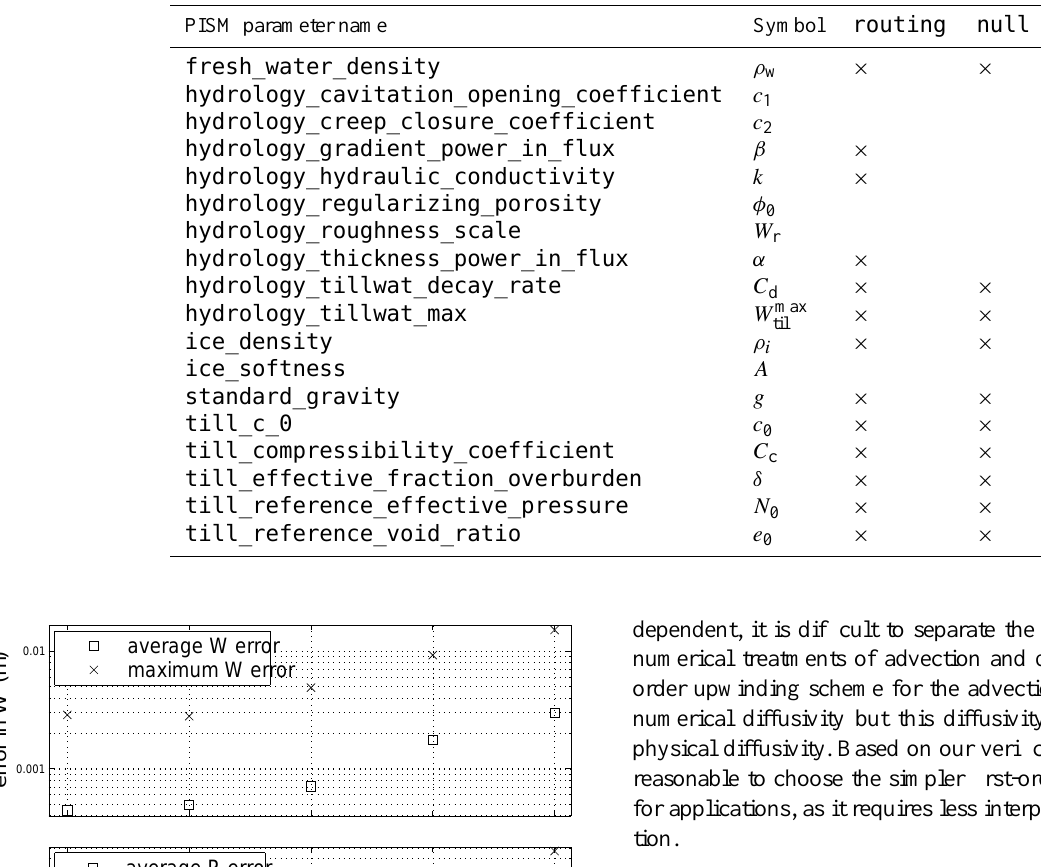
Table 3. Correspondence between PISM parameter names and symbols in this paper (Table 1). All are used in the distributed model, with indicated subsets used in the routing and null models.